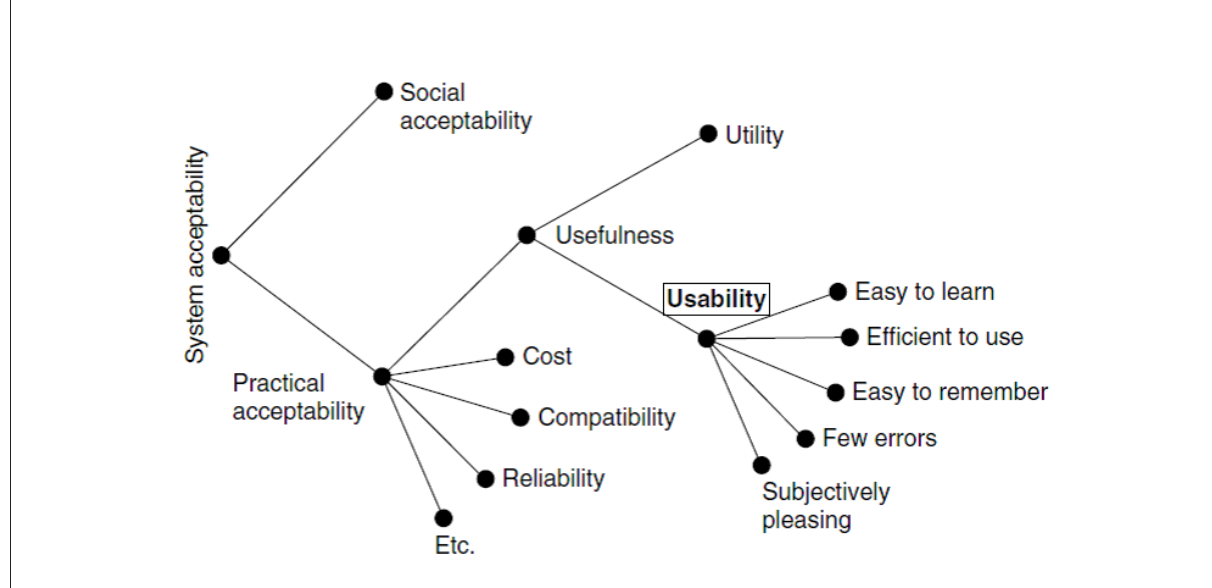
Figure 1: System acceptability